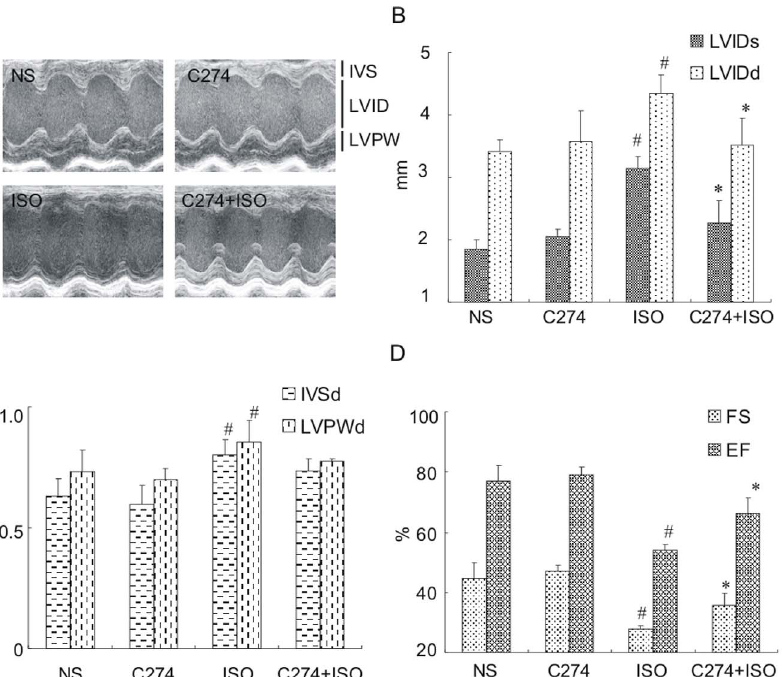
Figure 6. C274 attenuates echocardiographic changes induced by isoproterenol in vivo . (A) Shown are representative long-axis parasternal echocardiographic images. IVS, interventricular septum; LVPW, left ventricular posterior wall; LVID, left ventricular internal dimension. Mice (6–8 in each group) were subjected to treatment with vehicle control (NS), C274 (5 mg/kg, i.p.), isoproterenol (50 mg/kg, s.c.) or isoproterenol preceded by C274 (5 mg/kg, i.p.) for 6 d. Echocardiography was performed under inhalational isoflurane/oxygen anasthesia 24 h after last drug injection. (B, C) Comparison of IVSd, LVPWd and LVIDs, LVIDd for animals shown in (A) ( n =6-8, # p , 0.05 versus NS group, * p , 0.05 versus ISO group, Student’s t test). (D) Comparsion of fractional shortening (FS) and ejection fraction (EF) for animals shown in (A) ( n =6-8, # p , 0.05 versus NS group, * p , 0.05 versus ISO group, Student’s t test). FS = (LVIDd-LVIDs)/LVIDd 6 100 and EF = (LVIDd 3 - LVIDs 3 )/LVIDd 3 6 100. to cardiac echo 24 h after the last drug application. Representative (Fig. 7A-D) and cardiac cell death/fibrosis (Fig. 7E). Western blot cardiac echo images and measured parameters are depictured in Fig. 6. As expected, mice with isoproterenol injection showed an enlarged left ventricular chamber size as reflected by a significant increase in left ventricular internal dimension values at end diastole (LVIDd) and end systole (LVIDs), compared to the NS control (Fig. 6B). Isoproterenol also resulted in significant wall thicking as evidenced by increased values in interventricular septal (IVSs) dimensions at end systole, and left ventricular post wall thickness at end diastole (LVPWd) (Fig. 6C). Consistently, these structural alterations were accompanied by marked impairment in ventricular fractional shortening (FS), and ejection fraction (EF) (Fig. 6D). By comparison, pretreatment with C274 greatly reversed changes in almost all above parameters evoked by